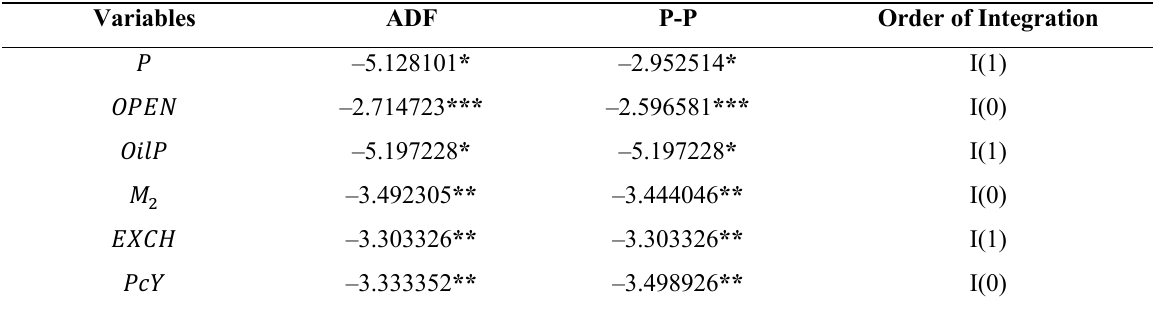
Table 1: Result of Unit Root Tests Variables Order of Integration